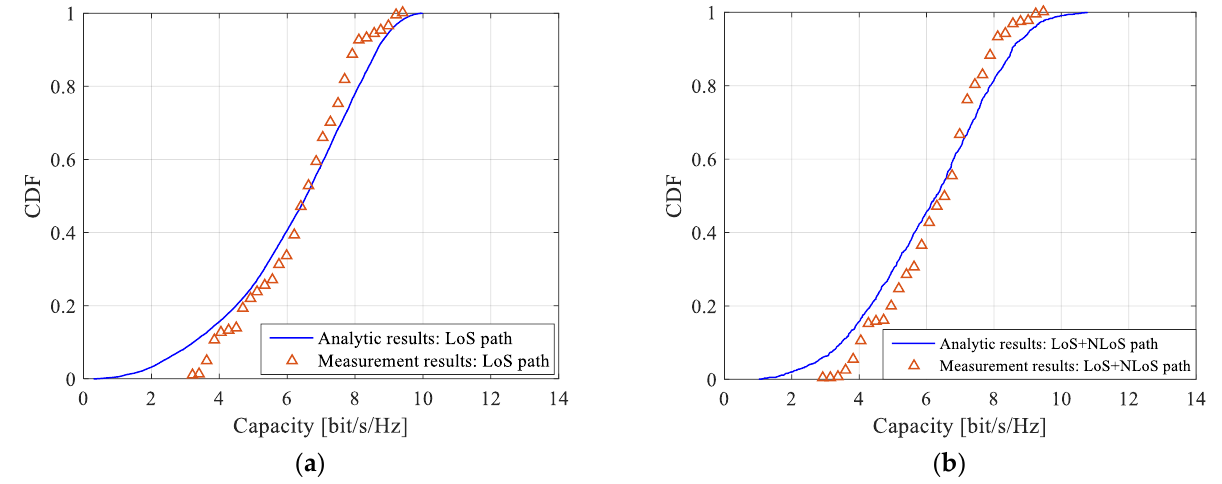
Figure 7. CDF of channel capacity: ( a ) LoS only path; ( b ) both LoS and NLoS paths. Table 6. Mean value of channel capacity.